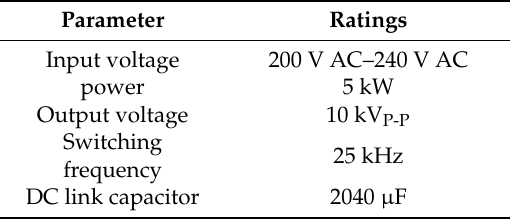
Table 2. The 10 kV, 5 kW PWM inverter for plasma power source design specification.